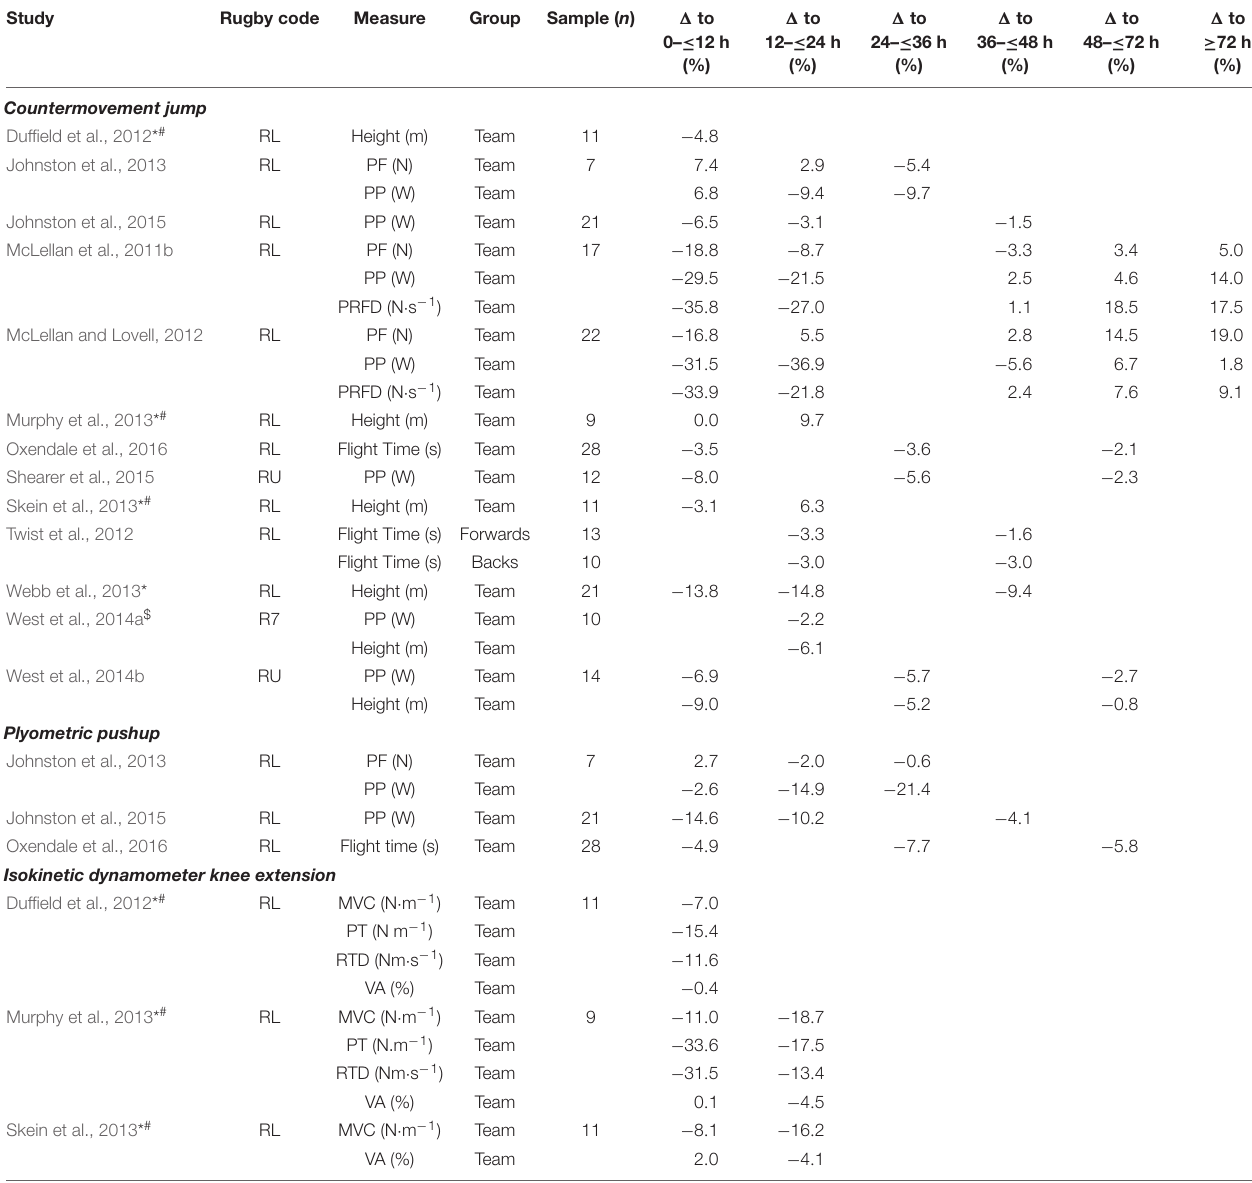
TABLE 1 | Neuromuscular performance changes across post-match